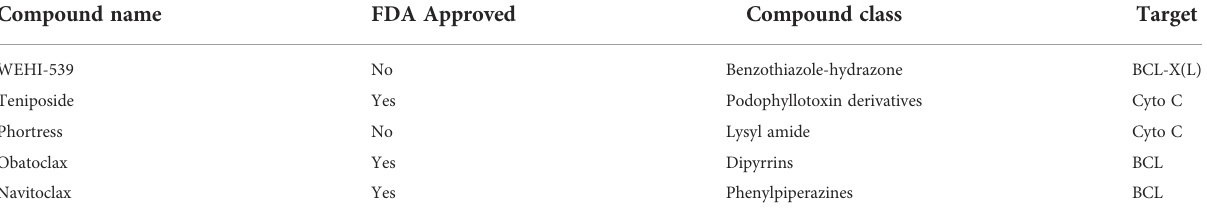
TABLE 1 List of Predicted drugs for inducing the expression of Cyto C w.r.t Glioma.